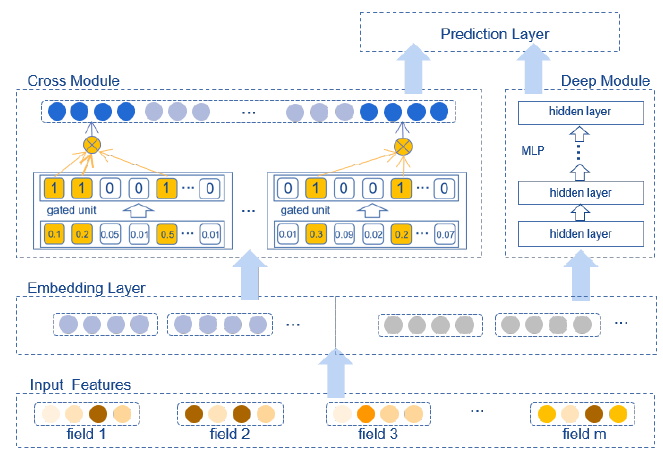
Figure 1. Architecture of